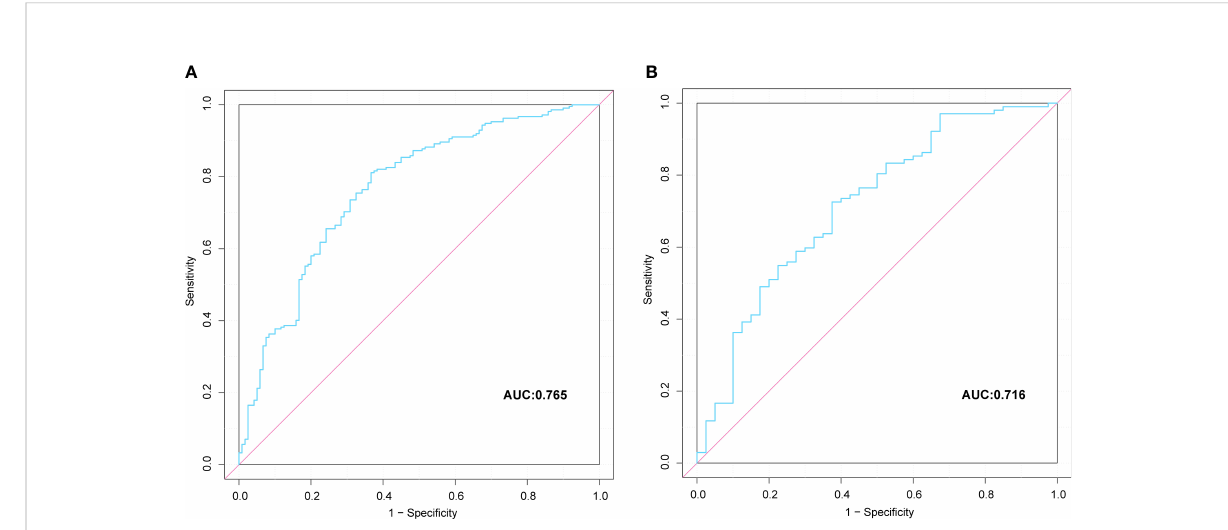
FIGURE 3 Comparison of the ROC curves of the nomogram for peripheral artery disease possibility prediction in the training set (A) , and in the veri fi cation set (B)